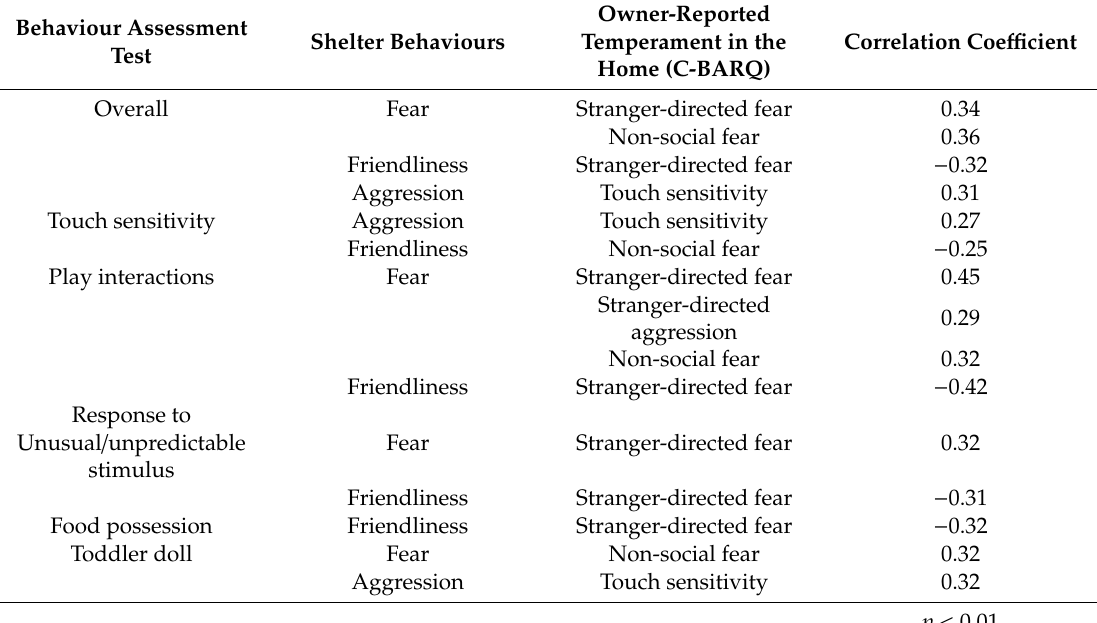
Table 3. Significant ( p < 0.01) Spearman rank correlations between the owner-reported dogs’ temperament / behaviour in the home and the behaviours derived from the formal behaviour assessment at the